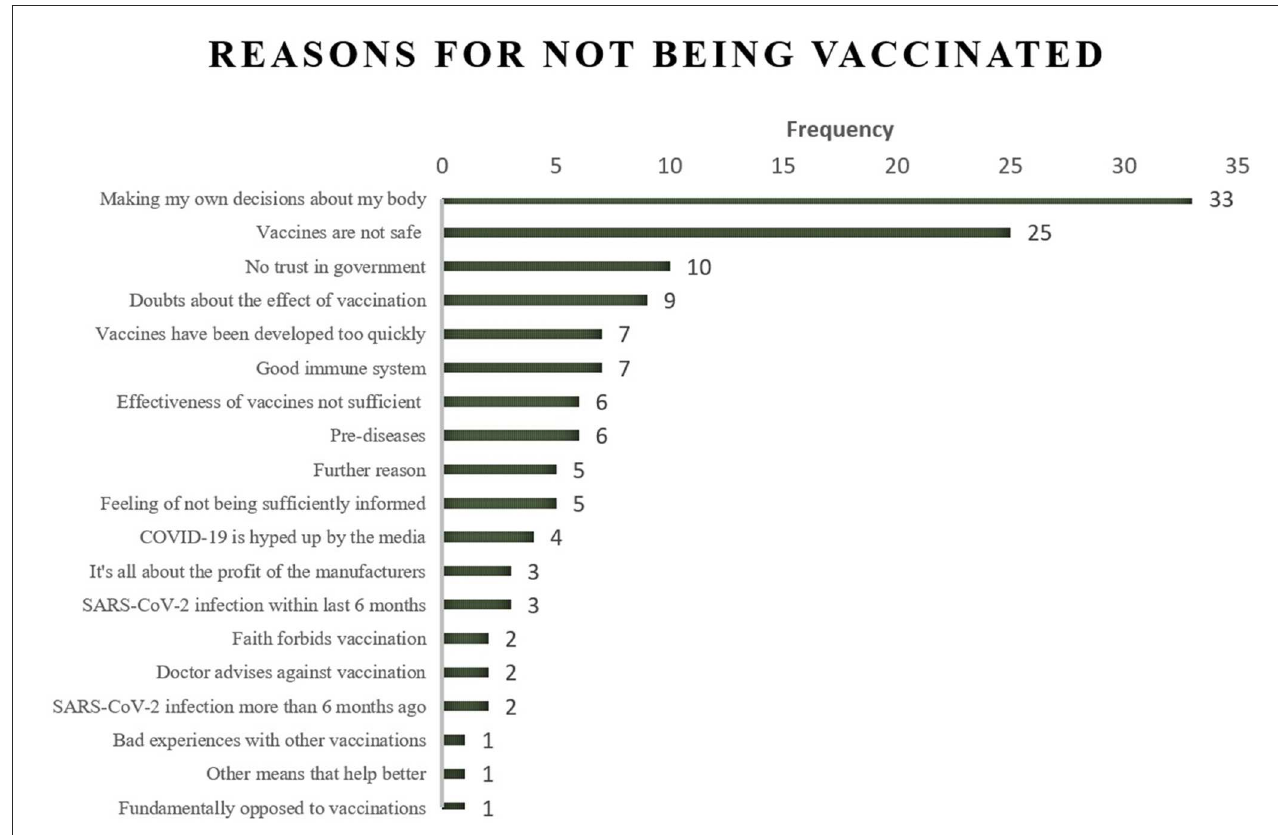
FIGURE2 Most important reason for not being vaccinated against COVID-19 ( N = 132). Not vaccinated respondents could state up to five reasons. Here the most important reason is